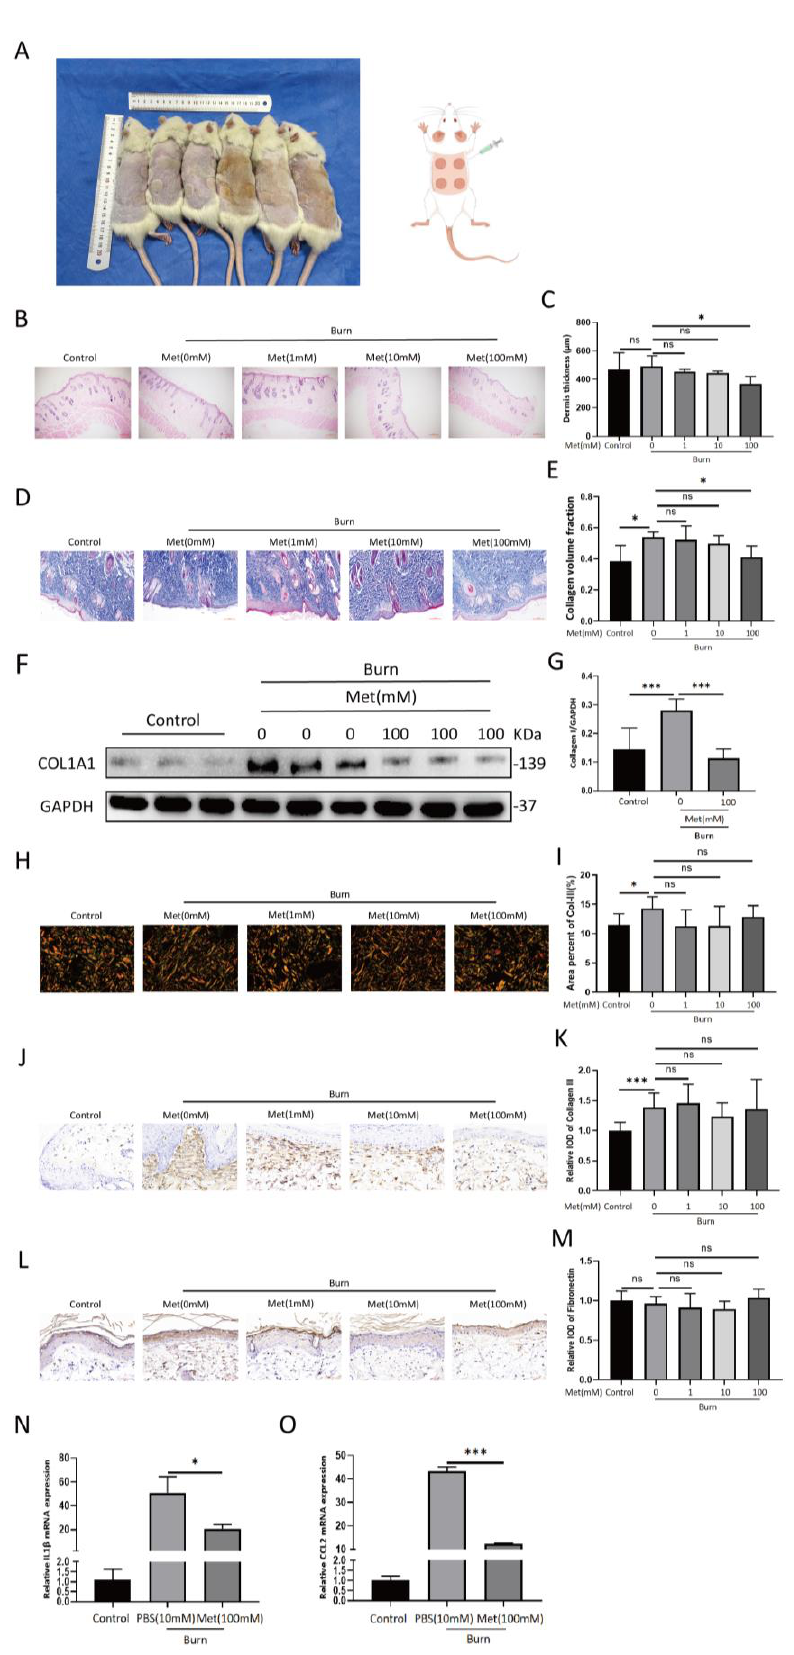
Figure 2. Metformin inhibits collagen I deposition and IL1β and CCL2 mRNA expression in a burn rat model. ( A ) A burn rat model is shown. Various concentrations of metformin (0, 1, 10, 100 mM) were subcutaneously injected into the dorsal burn wounds of the rats. ( B , C ) The rat s’ skins were